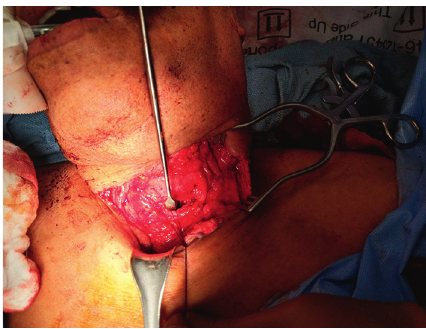
Figure 2: Tracheal